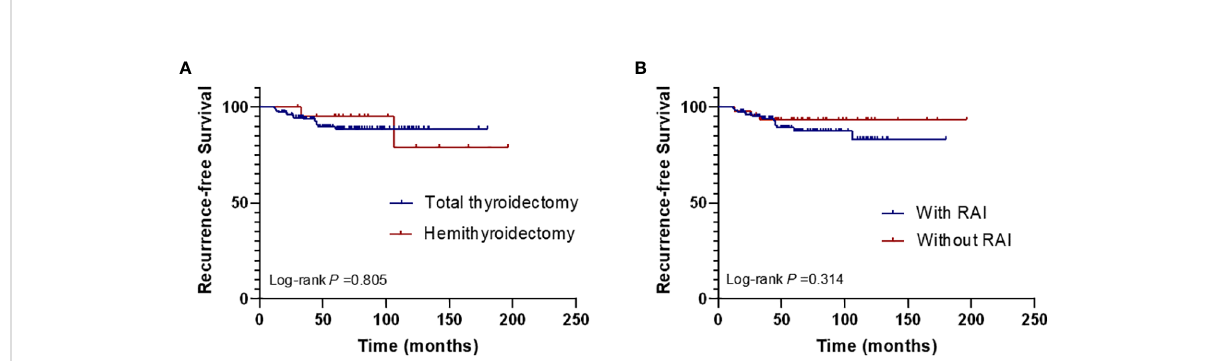
FIGURE 4 Kaplan – Meier curves for the recurrence-free survival according to the surgical scope of thyroid (A) and the postoperative RAI therapy (B) . (RAI, radioactive